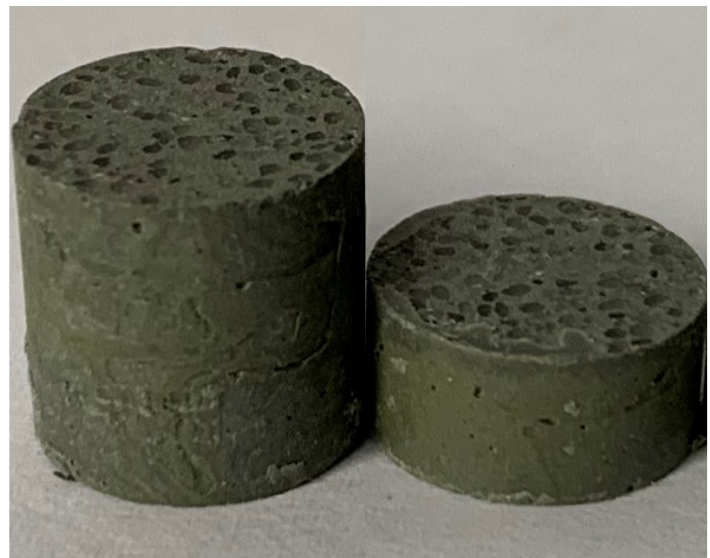
Figure 1. Photograph of test